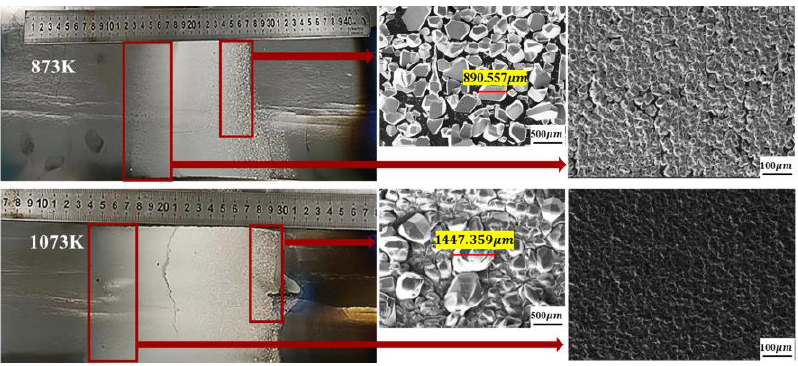
Figure 5. SEM images of the products in higher and lower distillation temperatures (873, 1073 K).